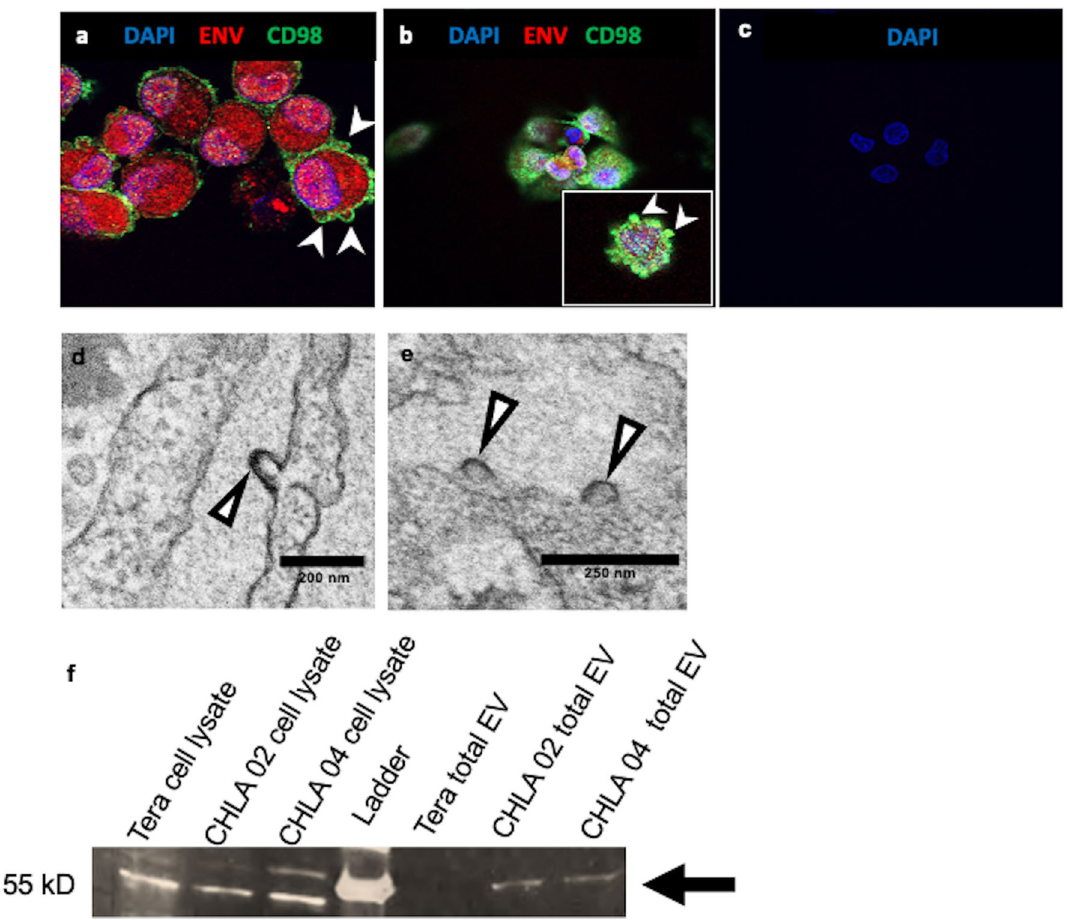
Figure 2. Extracellular Vesicles are released from CHLA 02 and CHLA 04 cells and contain HML-2 Envelope (Env). ( a , b ) AT/RT cells release extracellular vesicles contain HML-2 Env . ( a ) Immunostaining CHLA 02 cells with HML-2 env polyclonal antibody (surface unit) (red) and CD98 (green), a cell-surface marker, shows Env is expressed in extracellular vesicles enclosed by the plasma membrane. Cell nuclei are stained with DAPI (blue); ( b ) CHLA 04 cells similarly immunostained; magnification is at 63X. ( c ) CHLA 02 cells incubated with secondary antibody only as a control for nonspecific immunostaining. ( d , e ) Electron microscopy shows extracellular vesicles forming on plasma membrane of CHLA 02 AT/RT cells (arrow heads). ( f ) Cell lysates from Tera, CHLA 02, and CHLA 04 cells express HML-2 env (left three lanes) while only purified extracellular vesicles from CHLA 02 and CHLA 04 express HML-2 env (three right lanes) on immunoblot (arrow). A fluorescent Zeiss confocal microscope (LSM510) was used to acquire images processed with Zeiss LSM 5 Image Browser and Microsoft PowerPoint for figure creation (https:// www. embl. de/ eamnet/ html/ downl oads. html). The gel image has been cropped to focus on the bands of interest, the full gel image can be found in the supplementary material. Gel Image was taken with a FluorChem E system (https:// www. prote insim ple. com/ fluor chem. html) and images were processed with ImageJ and Microsoft PowerPoint for relative densitometry quantification and display. Electron microscopy images were taken with a JEOL 1200 EXII Transmission Electron Microscope (AMT digital camera